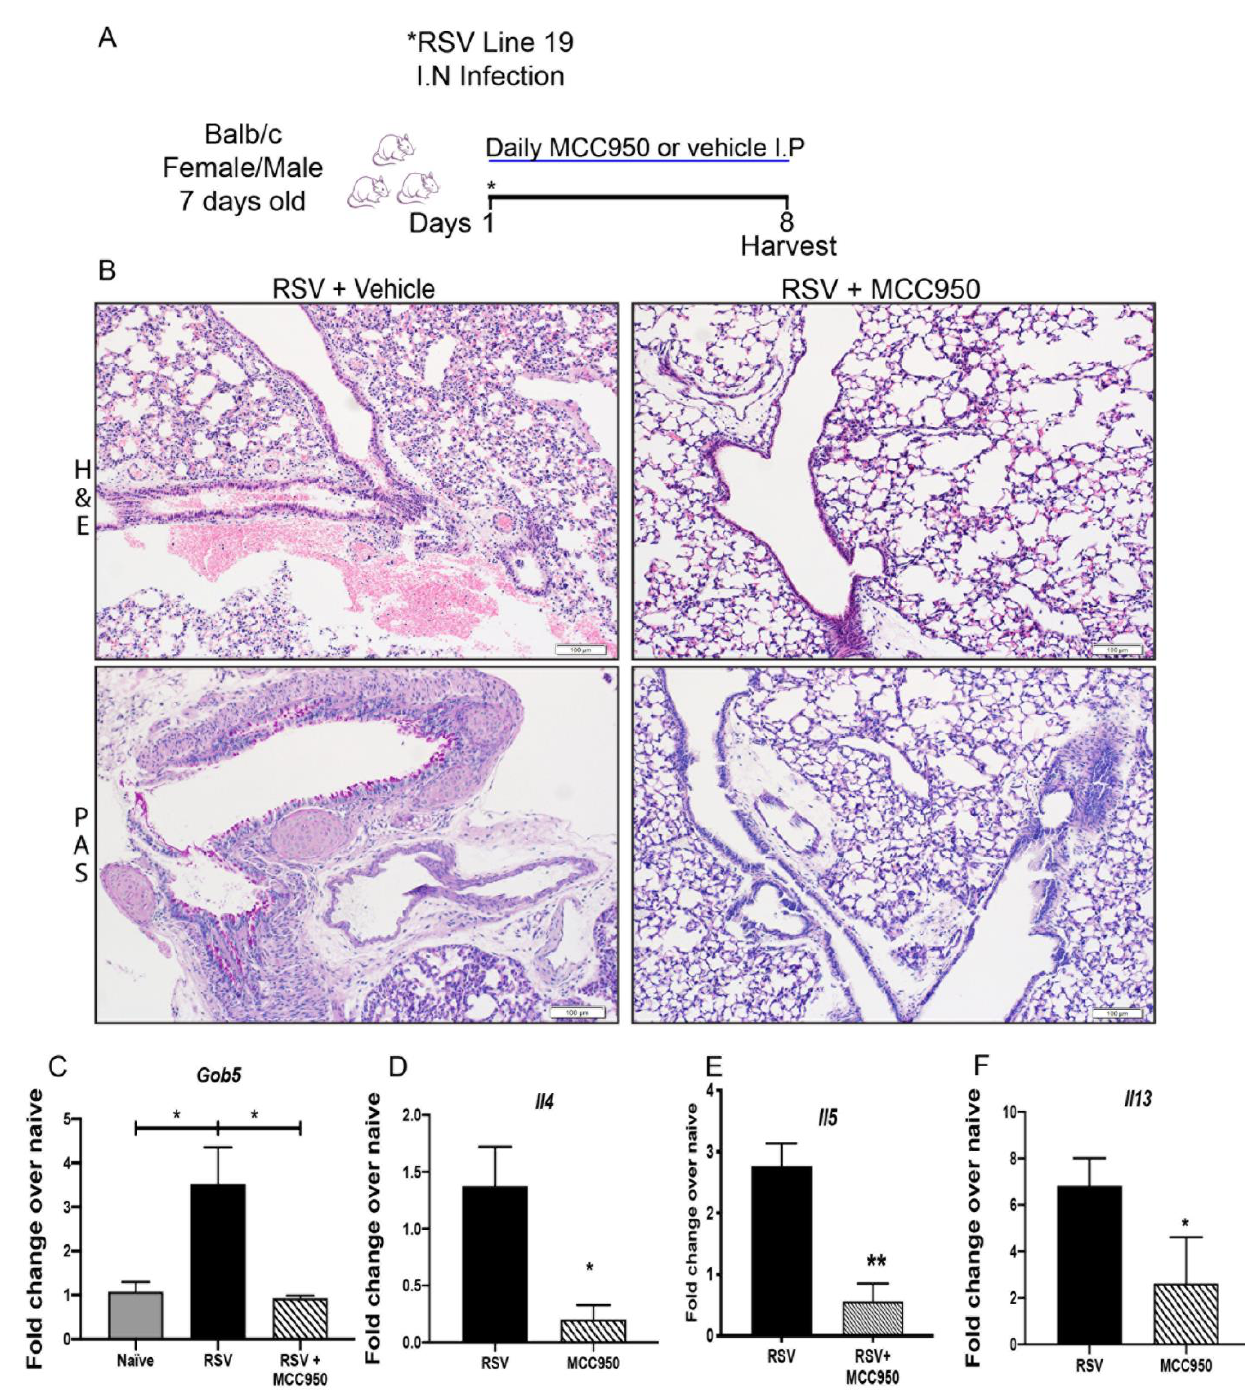
Figure 3. NLRP3-inflammasome inhibition modifies RSV immunopathology in neonate mice. ( A ) 7-day old female and male BALB/c mice were infected intranasally with Respiratory Syncytial Virus (RSV), Line 19 and treated daily with either an NLRP3 inhibitor (MCC950) or vehicle intraperitoneally; samples were harvested at 8 days post-infection. ( B ) Lung histopathology in Hematoxylin and Eosin stain (H&E) showed strongly reduced lung inflammatory infiltration and Periodic acid-Schiff stain (PAS) detected mucus that was decreased in the RSV+MCC950 group compared with control RSV+ Vehicle. Scale bar = 100 μm. ( C ) Decreased Gob5 lung mRNA expression. ( D ) Il4 , ( E ) Il5 , ( F ) Il13 lung mRNA expression. Data represent the Mean ± SEM from 4 to 8 mice (experimental repeats 2). * p ≤ 0.05, ** p ≤ 0.01.